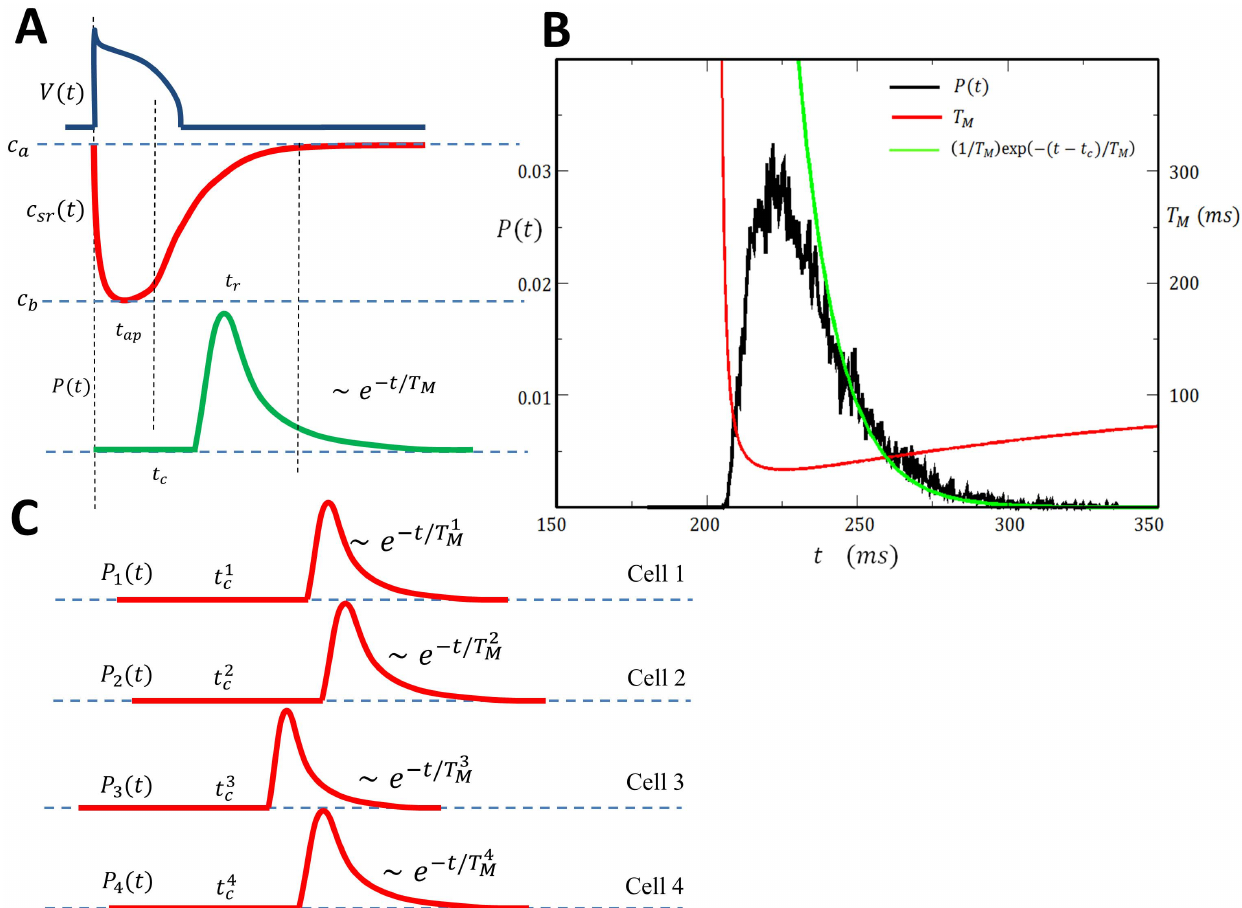
Figure 4. (A) Schematic illustration of the voltage time course, SR Ca concentration, and the FPD, following an AP. (B) Plot of P ( t ) (black line) computed using the exact stochastic algorithm with time dependent excitability according to Eq. (29). Probability distribution is computed by binning the first passage time of 10 5 independent samples. The parameters used are k z ~ 10 { 2 ( m M ) { 2 ms { 1 , b ~ 1 = 20, M ~ 100 . Red line corresponds to a plot of T M using Eq. (27). The units of T M is indicated on the right y-axis. Late time behavior of P ( t ) is fitted using an exponential with decay rate T M (green line). (C) Schematic illustration showing cell-to-cell variations of the FPD P i ( t )